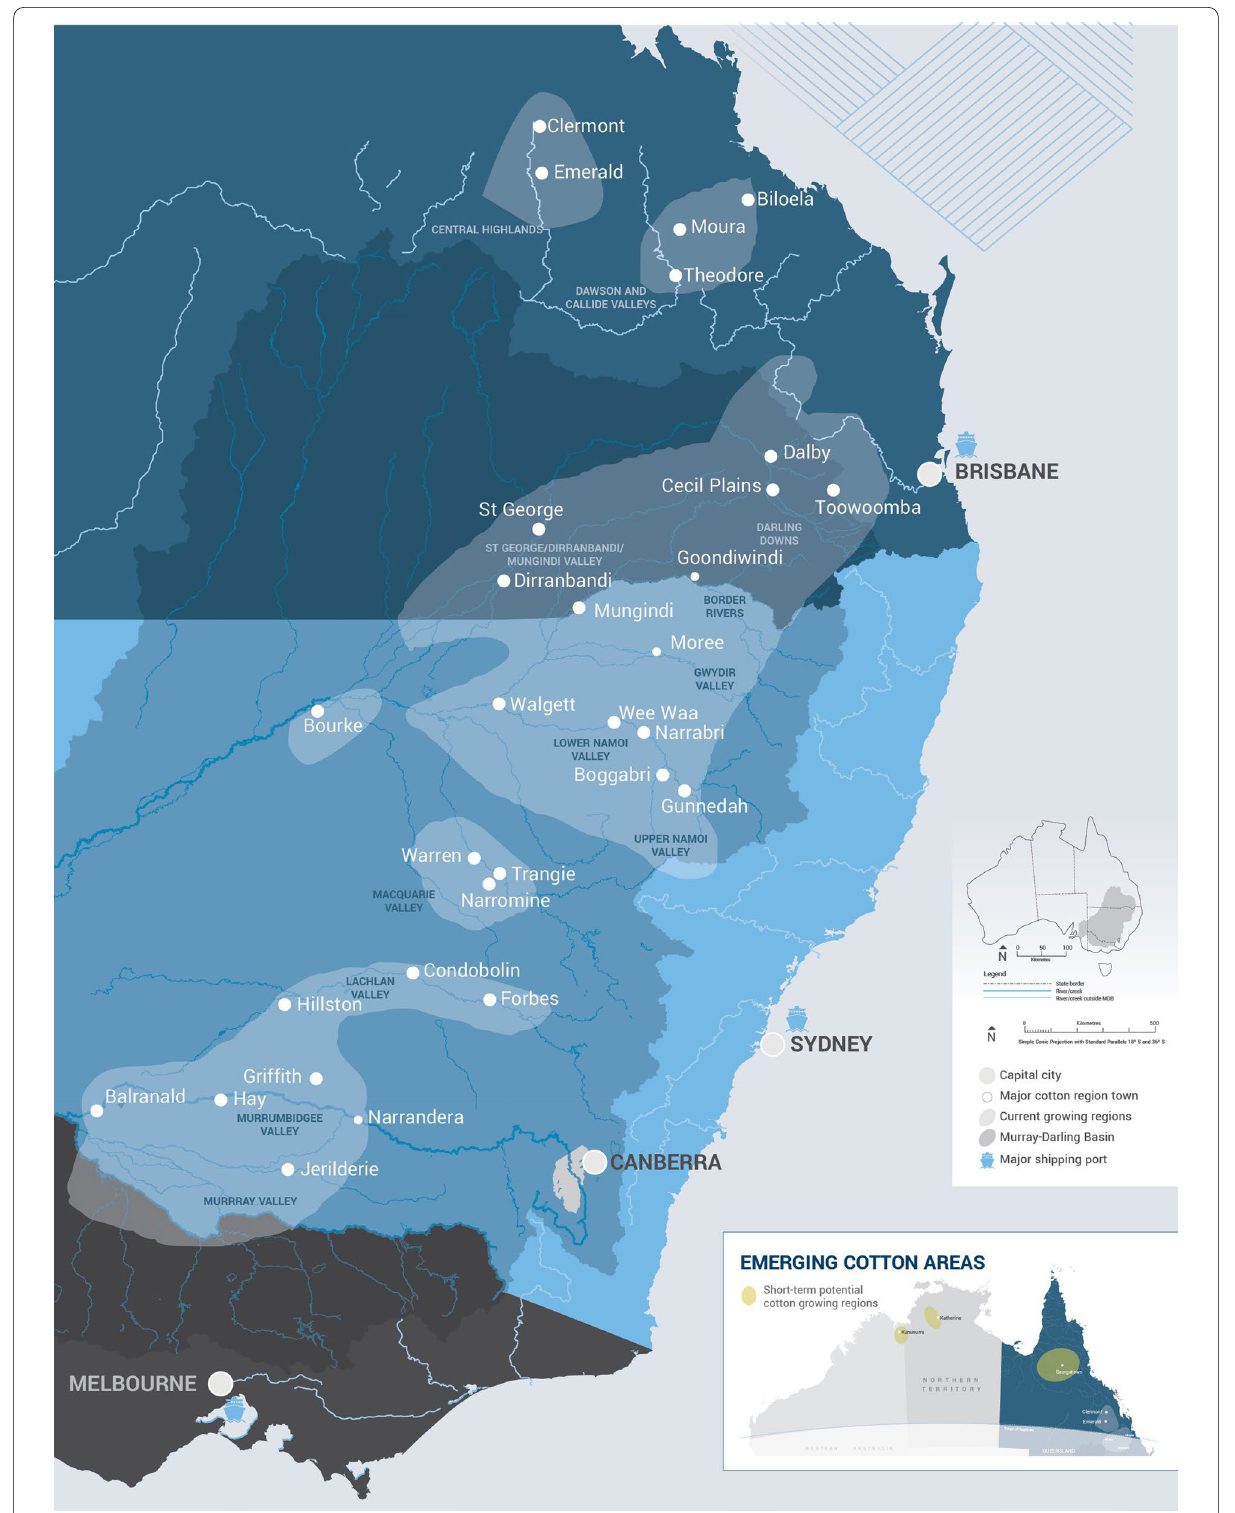
Fig. 1 Australian cotton growing regions and emerging areas ( Source : Cotton Australia